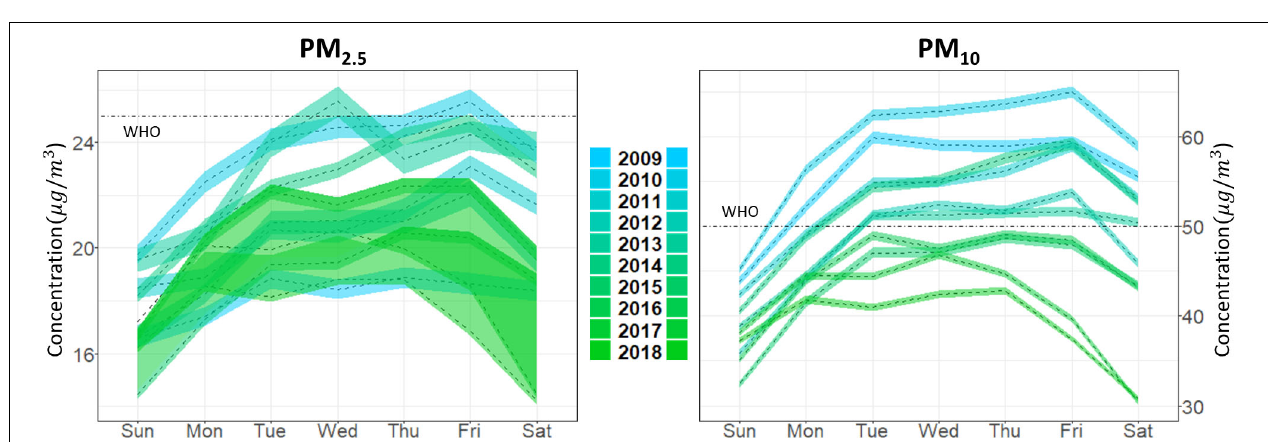
FIGURE 11 | Daily aggregated data for PM 2 . 5 (left chart) and PM 10 (right chart) measured concentrations (valid data only).